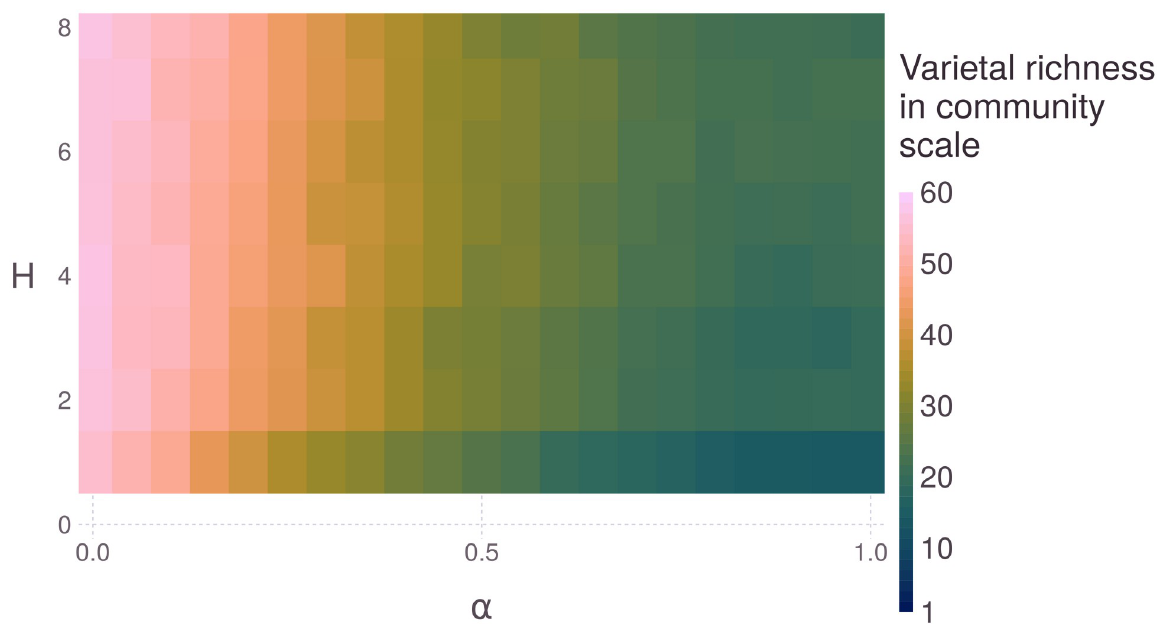
Fig 6. Phase diagram of the model’s final varietal richness at the community level as a function of parameters H and α . Parameter H is the resource heterogeneity, with H = 1 meaning there is only one set of resources in all plot fractions. Parameter α is the importance of productivity for calculating the variety score: an α = 0 score only considers quality fitting, and an α = 1 score only considers productivity. Each rectangle represents the aggregation of 100 runs for 10,000 agricultural